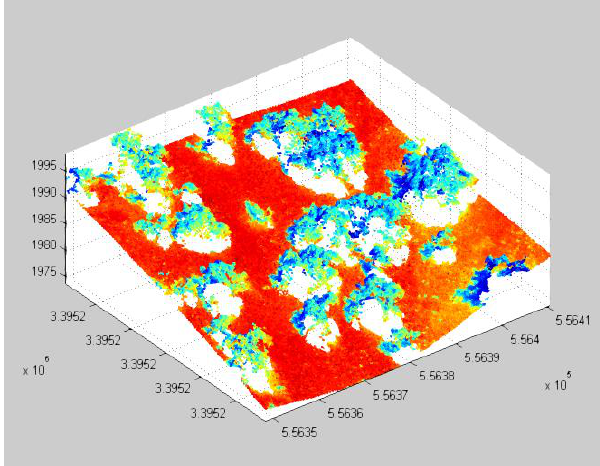
Figure 3. point clouds in red bound.